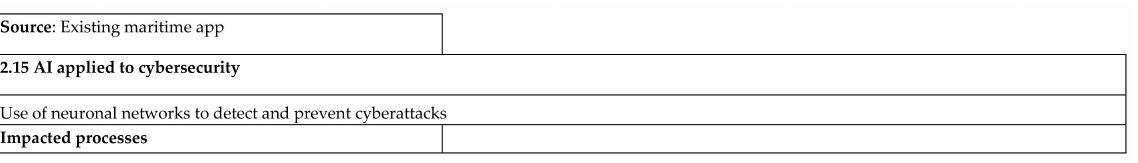
Figure A18. Optimizing ship’s operations via AI analysis of operational information data sheet.